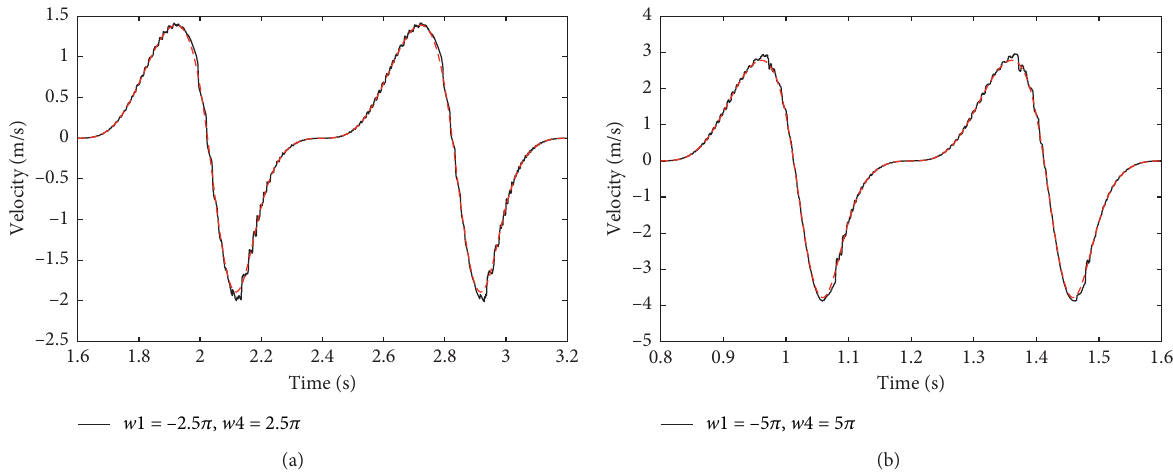
Figure 16: Velocity of the slider. (a) ω